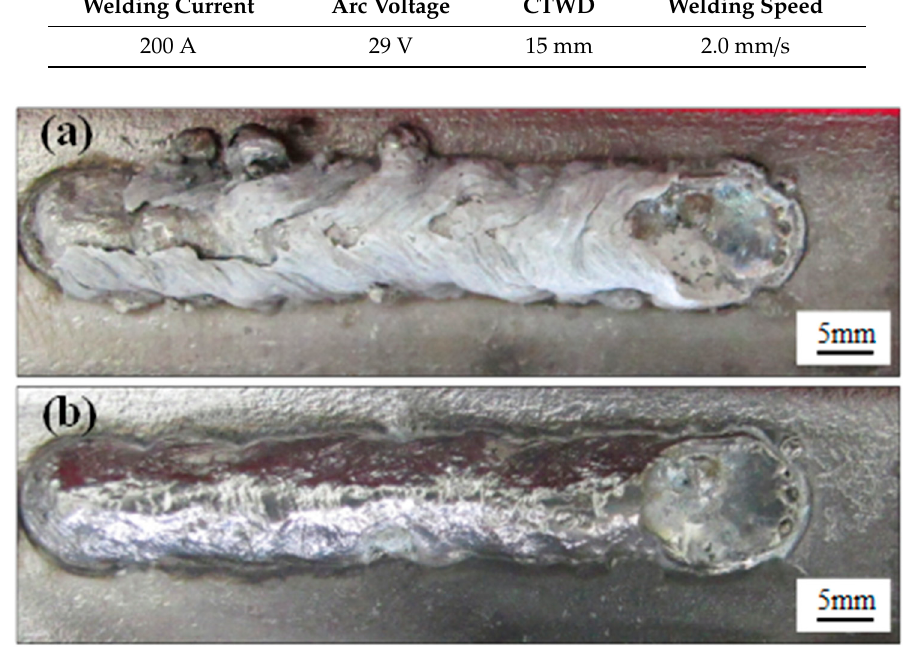
Table 4. Optimal welding parameters.